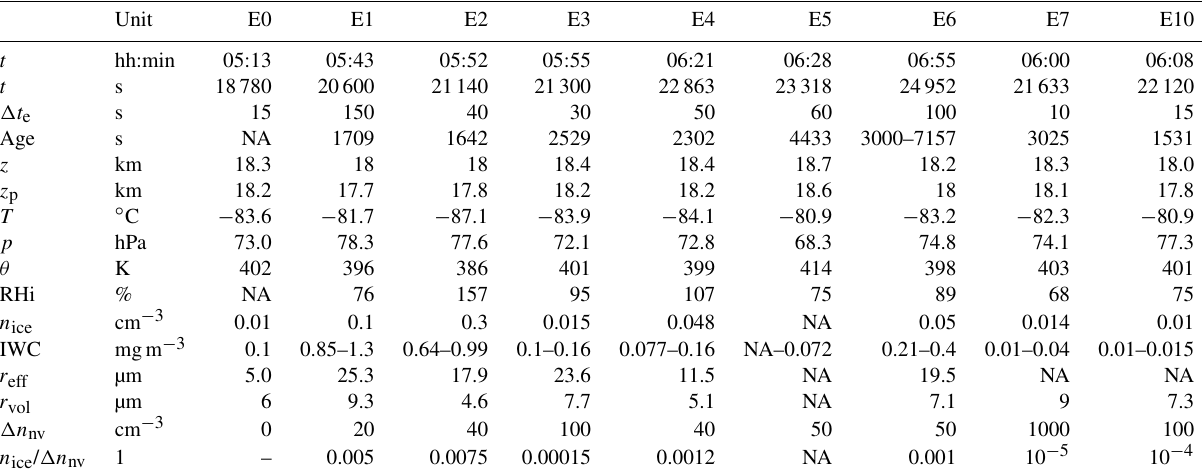
Table 3. Mean properties ∗ of ice events, E1–E6 from de Reus et al. (2009) and short-term ice events E0, E7, and E10 for 30 November 2005 (NA for not